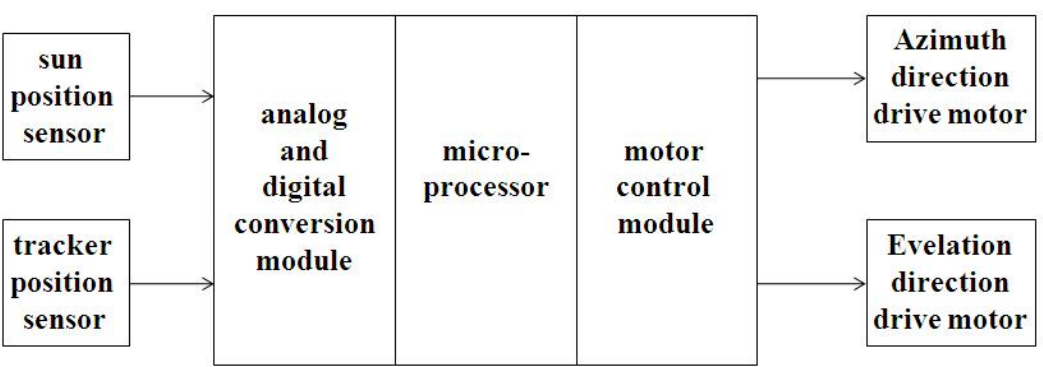
Figure 2. Sun tracking control system.